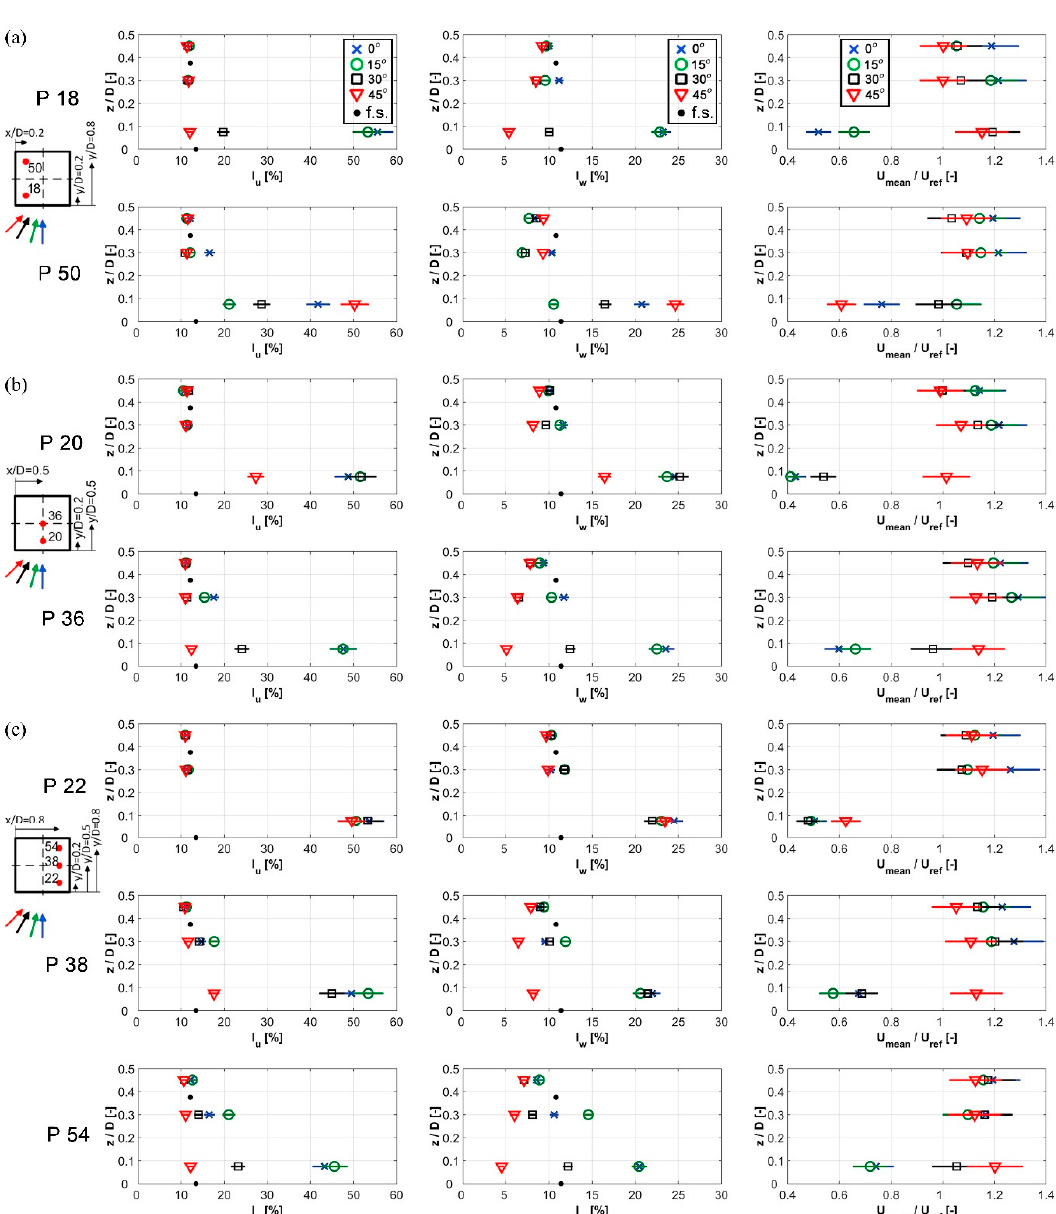
Figure 8. Stream-wise ( I U ) and vertical ( I W ) turbulence intensity, and normalised stream-wise velocity U/U ref with uncertainty limits, as measured above the flat roof at 0°, 15°, 30° and 45°. Measurement points include: ( a ) 18–50 (marked line x/D = 0.2), ( b ) 20–36 (marked line x/D = 0.5) and ( c ) 22–38–54 ( x/D = 0.8). Free-stream reference values (at the inlet profile shown in Figure 3) are also marked for the turbulence intensity (•).